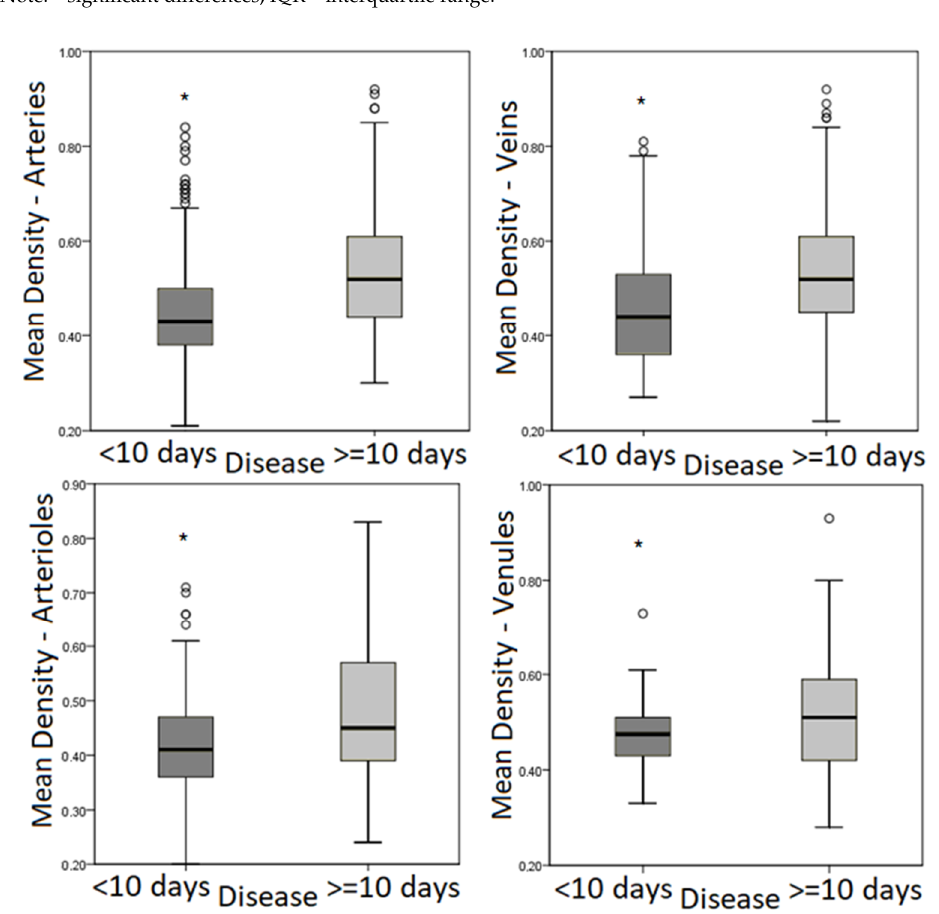
Figure 4. Box plot diagram showing distribution of median values and quartiles of mean optical density in the pulmonary vascular endothelium in groups of patients with disease duration of more/less than 10 days. Note: * significant differences.